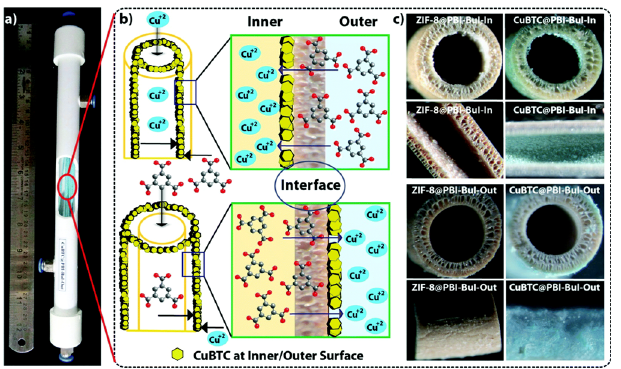
Figure 5. ( a ) Representative digital photograph of a gas separation module (CuBTC growth on the outer surface of the PBI-BuI hollow fibres (CuBTC@PBI-BuI-Out) is seen through the cut); ( b ) schematic for the interfacial synthesis approach of CuBTC@PBI-BuI-In and -Out; and ( c ) microscopic images of the ZIF-8@PBI-BuI-In, ZIF-8@PBI-BuI-Out, CuBTC@PBI-BuI-In, and CuBTC@PBI-BuI-Out composites synthesised. Reprinted with permission from [71], The Royal Society of Chemistry, Copyright (2015).